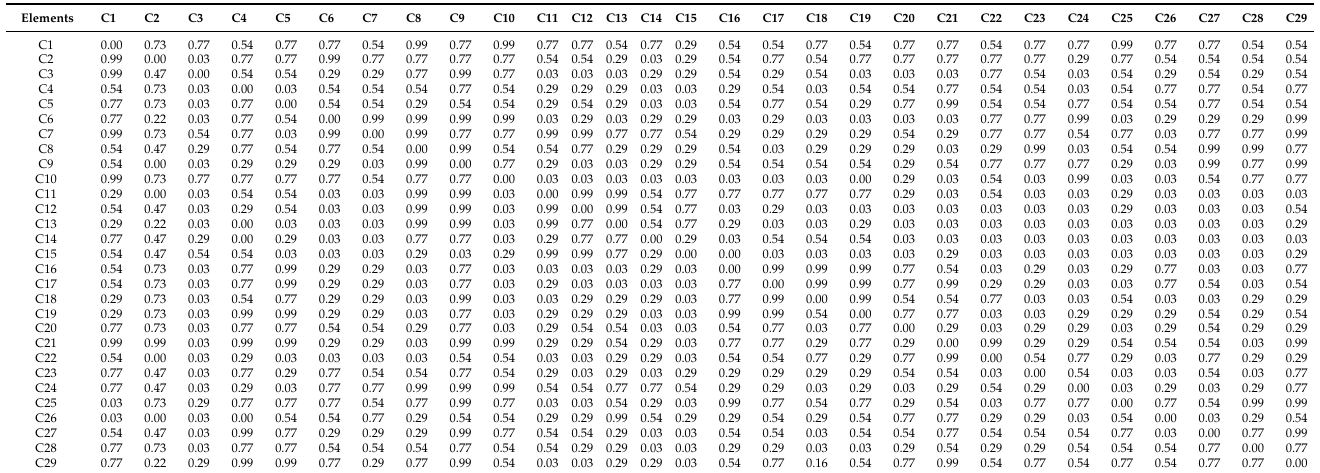
Table 4. Initial direct influence matrix after triangular fuzzy